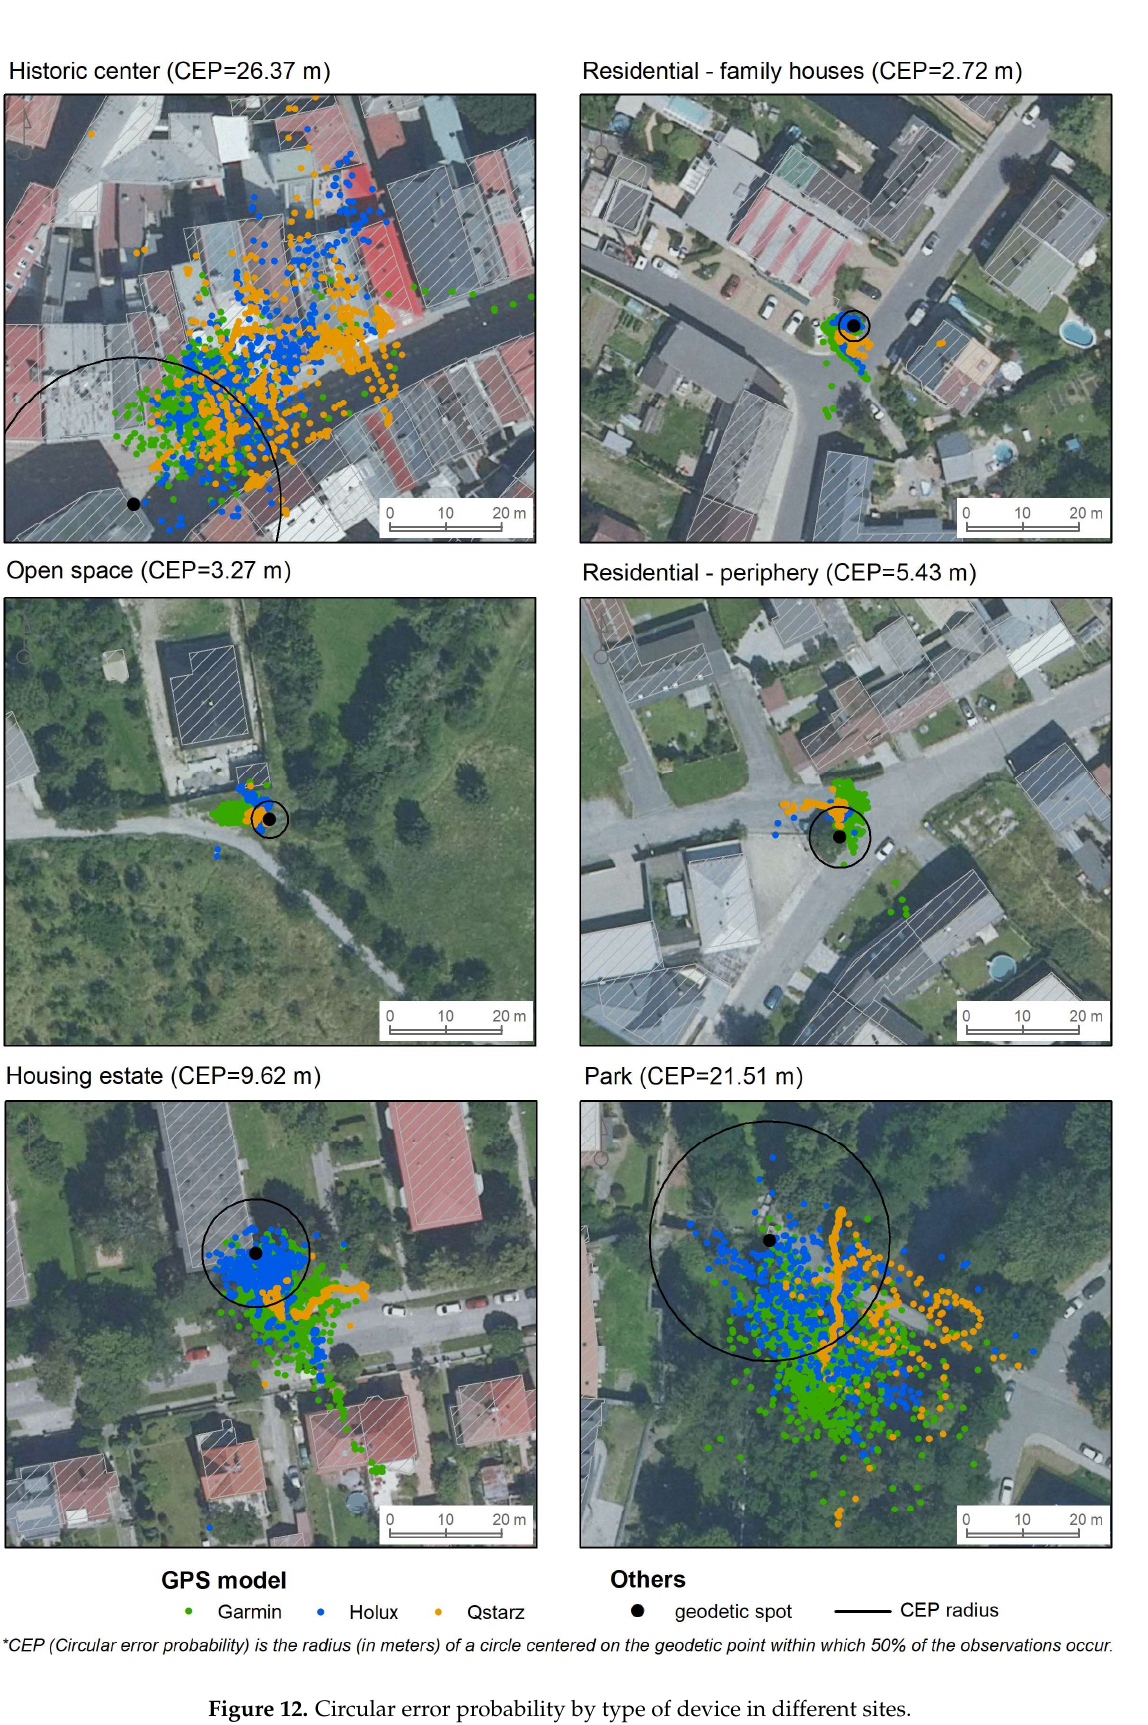
Figure 12. Circular error probability by type of device in different sites.